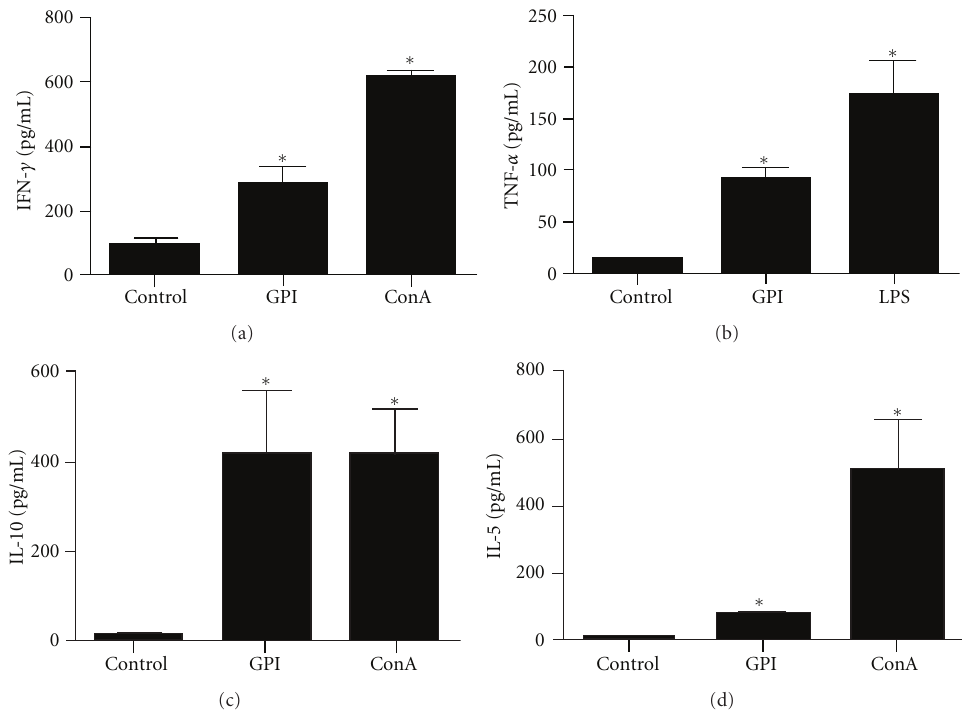
Figure 4: Cytokine profile of mice immunized with GPI-Proteins. Control group was immunized with PBS plus Freund adjuvant (CFA/IFA). One week after the last immunization, splenocytes from five mice were isolated and assayed for, IFN- γ , TNF- α , IL10 and IL5 production in response to GPI proteins (12.5 μ g/mL + CFA/IFA), or PBS + CFA/IFA as control. The results are presented as mean ± S.D. for each group. A statistically significant di ff erence of GPI vaccinated mice compared to control group is denoted by an asterisk for P < 0 . 05. Concanavalin A (ConA) and LPS were used as positive controls. Results are representative of two independent biological experiments.